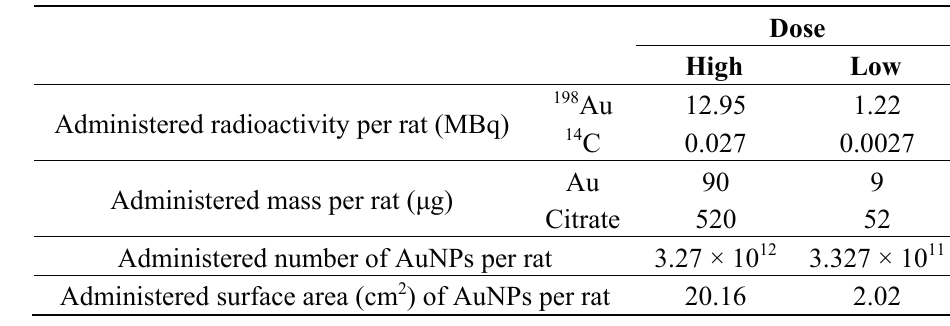
Table 1. Characteristics of the dual-radiolabeled AuNPs used in the study at the 2 dose levels used (high and low). The surface area of the AuNPs was calculated using the primary size determined using TEM.